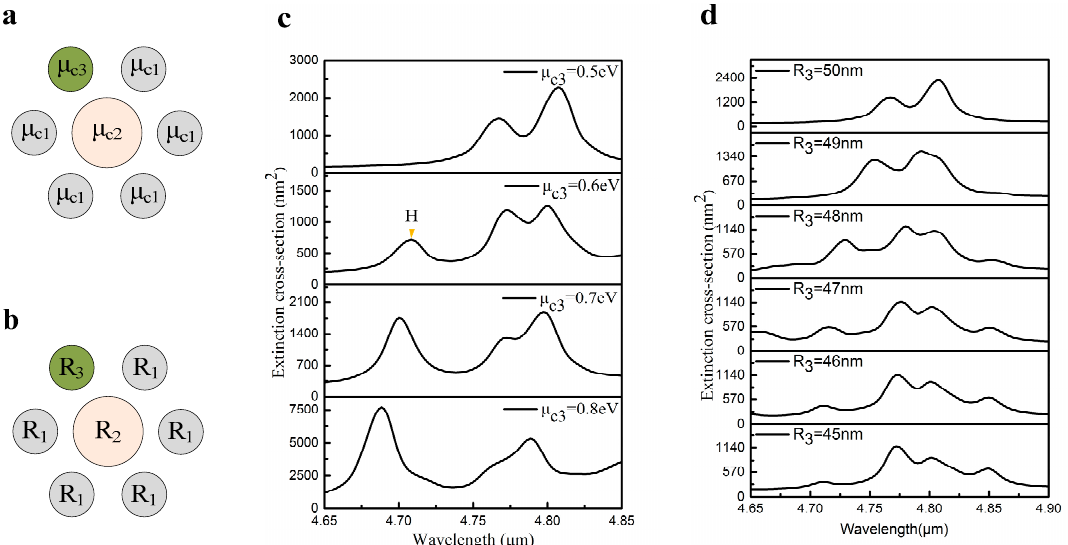
Figure 5. ( a ) The chemical potential of the upper left nanodisk is labeled as µ c 3 . ( b ) The radius of the upper left nanodisk is marked as R 3 . ( c ) The Fano dip disappears gradually when µ c 3 is varied from 0.5 eV to 0.8 eV. ( d ) The extinction spectra with the change of radius.